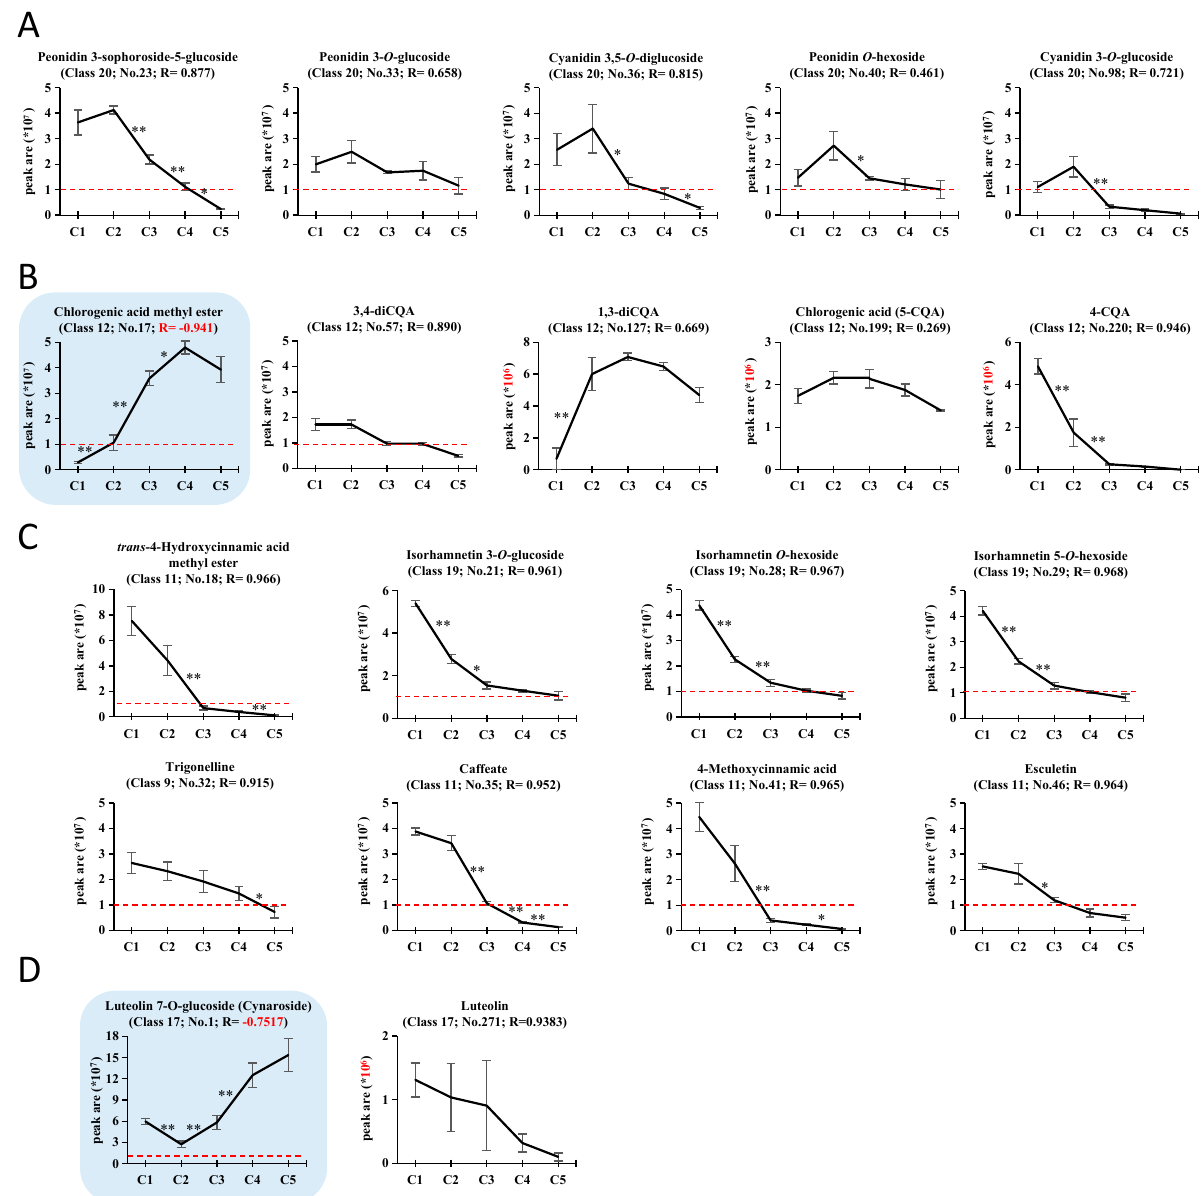
Figure 4. The accumulation of some possible functional compounds relating to the antioxidant capacities. ( A ) The five anthocyanins from Class 20, which are key to leaf color change during JFR. ( B ) Chlorogenic acid (5-CQA) and its derivatives from Class 12. Among the five metabolites, “chlorogenic acid methyl ester” was the only one within the top 50 abundant compounds with R < − 0.9, and was highlighted by blue shade. ( C ) The eight compounds within the top 50 abundant compounds with R > 0.9. ( D ) Cynaroside and luteolin. Cynaroside had negative R, and was highlighted by blue shade. The class, ranking number, and R value are shown for each compound. Red dashed lines represent the abundance peak area of 1 × 10 7 . The Y -axes for luteolin and the three CQAs not exceeding 1 × 10 7 were indicated in red. Values are expressed as means ± SE, n = 3. The difference significance for adjacent stages are indicated by * ( p < 0.05) and ** ( p < 0.01).